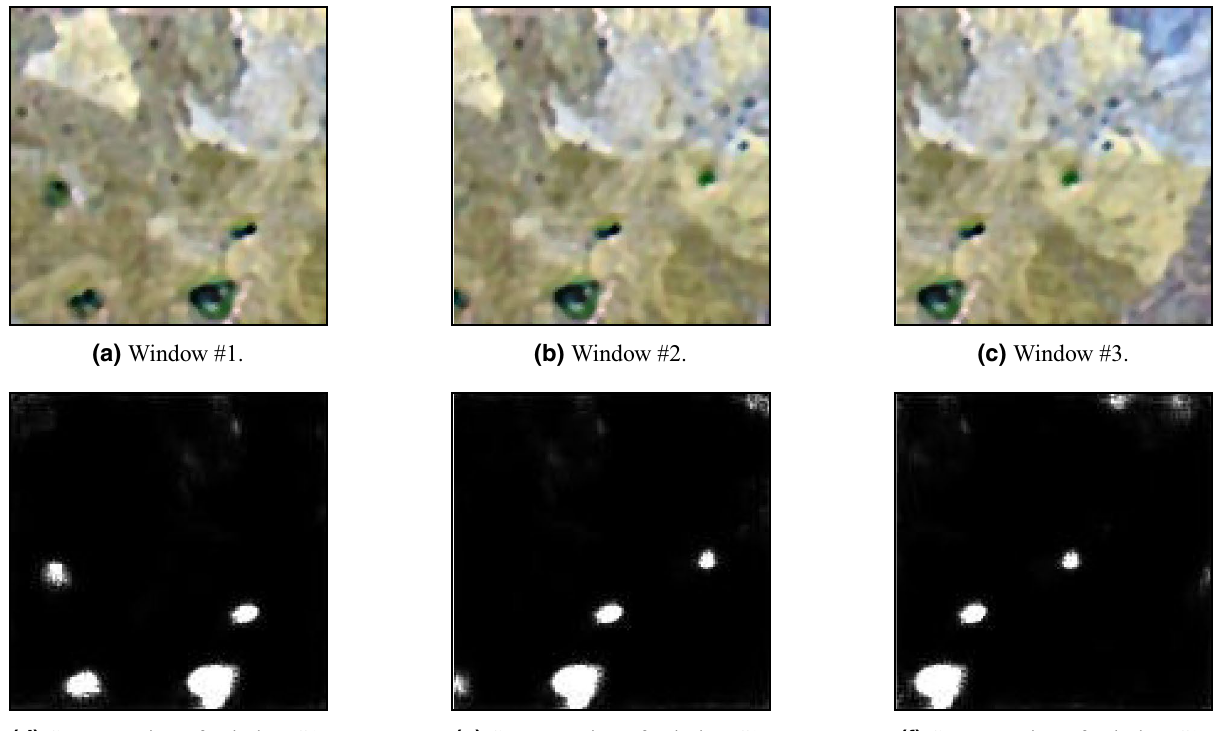
Figure 6. Squares of impurities and their segmentation.